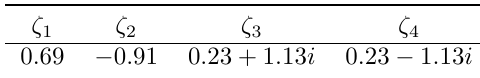
Table 3: ζ roots from Equation 17